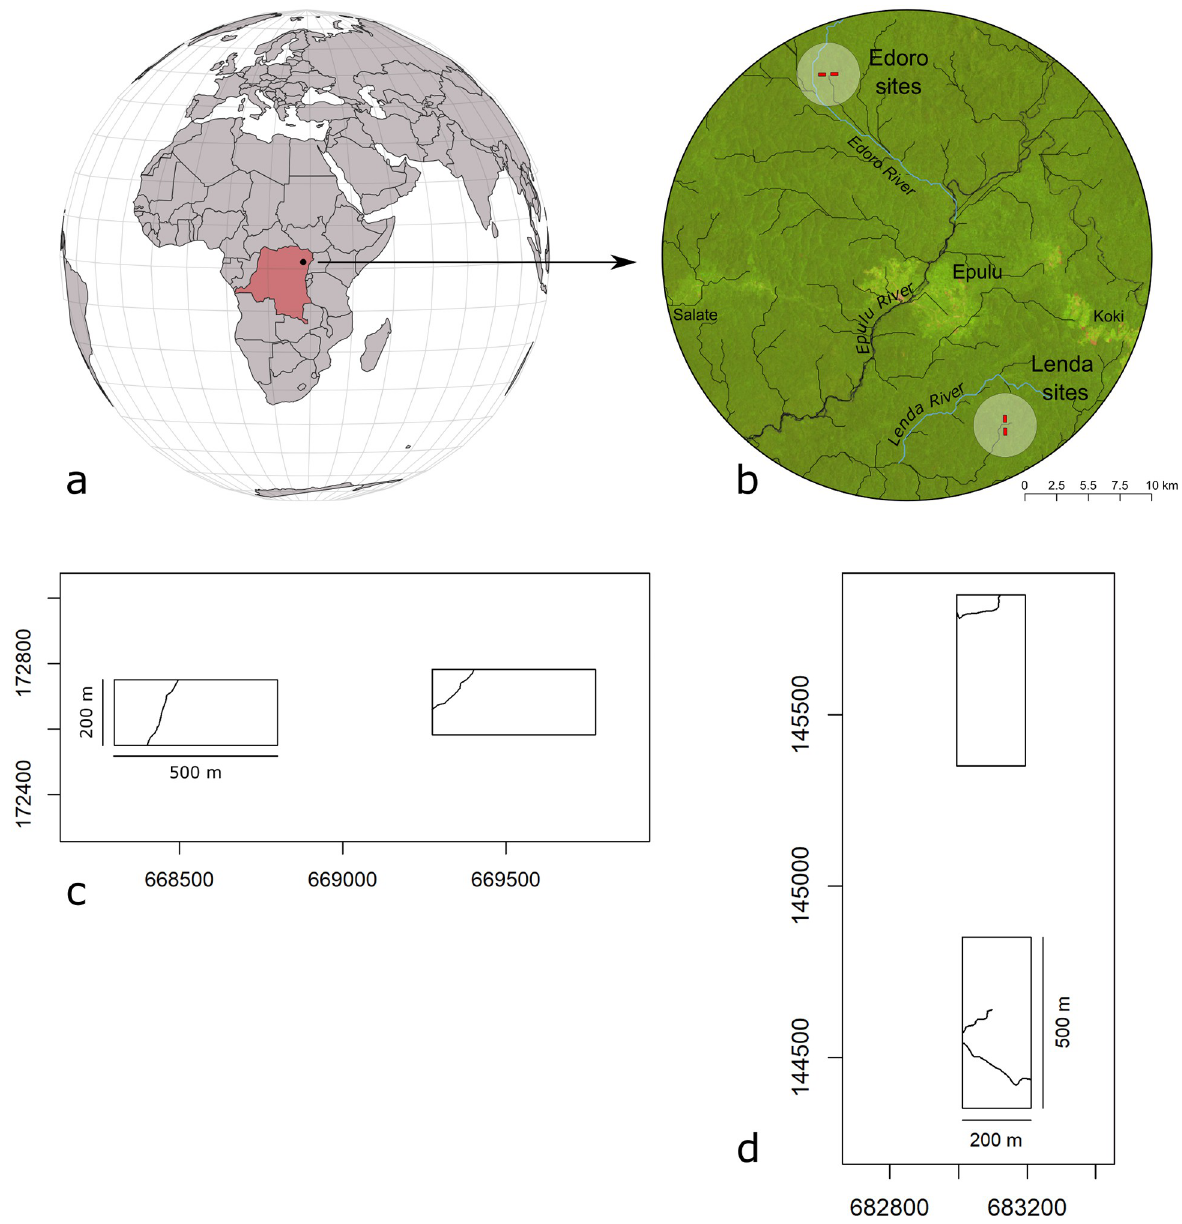
Fig 1. Overview of study area and Ituri Forest Dynamics Project field plots. The location of Ituri field plots in the DRC (a); regional context, showing the two sets of field plots, named for their proximity to the Edoro and Lenda Rivers (b); and local context, showing Edoro (c) and Lenda (d) field plots with minor plot-level hydrological features digitized from [29]. The eastern Edoro plot was omitted from analysis due to lack of Gilbertiodendron . Basemap from Global Land Analysis & Discovery laboratory 2019 Landsat mosaic. Regional hydrological features derived through hydrological analysis of 3 arc second Shuttle Radar Topography Mission digital elevation tile North 01 East